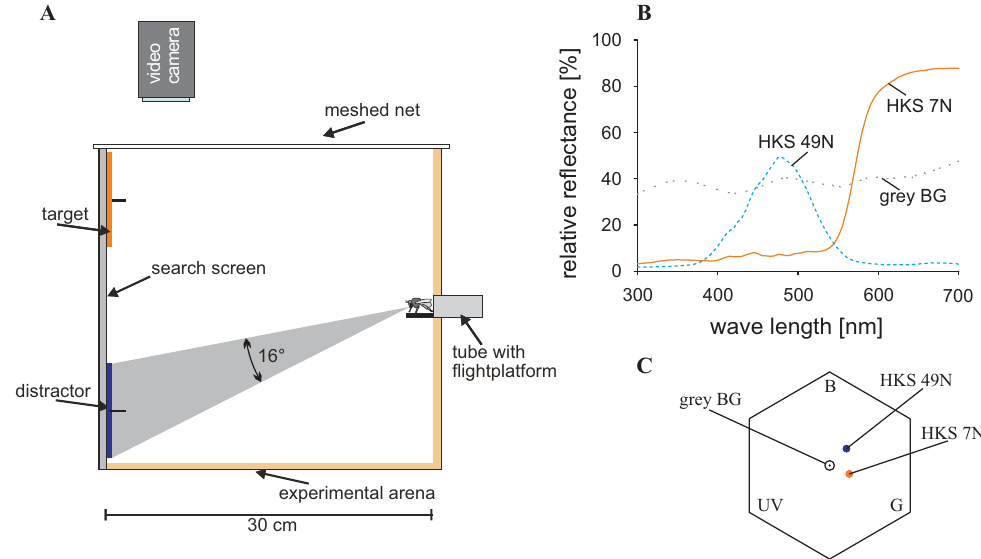
Figure 1. Experimental setup and colorimetry. A . Side view of the experimental arena. Bees enter the arena through a Plexiglas tube, view the objects on the search screen (back wall) and fly towards one of them. The bee’s flight could be observed and filmed through a small-meshed net from above and through a Plexiglas wall from the side. The number in the grey shaded area gives the angle of the target subtended on the bee’s eye when viewed from the entrance of the box. B . Reflectance curves of the search screen (grey BG - background), the orange target (HKS 7N) and the blue distractor (HKS 49N). C . Colour hexagon showing the colour loci of the target and the distractor (colour distance of HKS 7N to background: 0.23 hexagon units; HKS 49N to background: 0.25 hexagon units; distance between the two colours: 0.27 hexagon units); calculations after Chittka